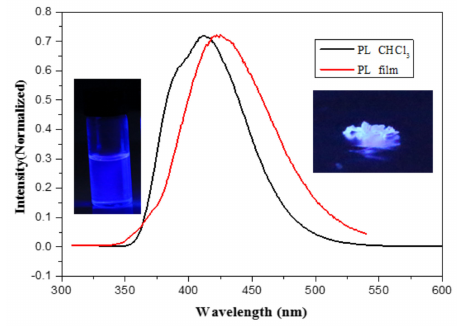
Figure 3. PL spectra of 1a . Inset are photographs of ground powder of 1a and 1a in toluene under 365 nm